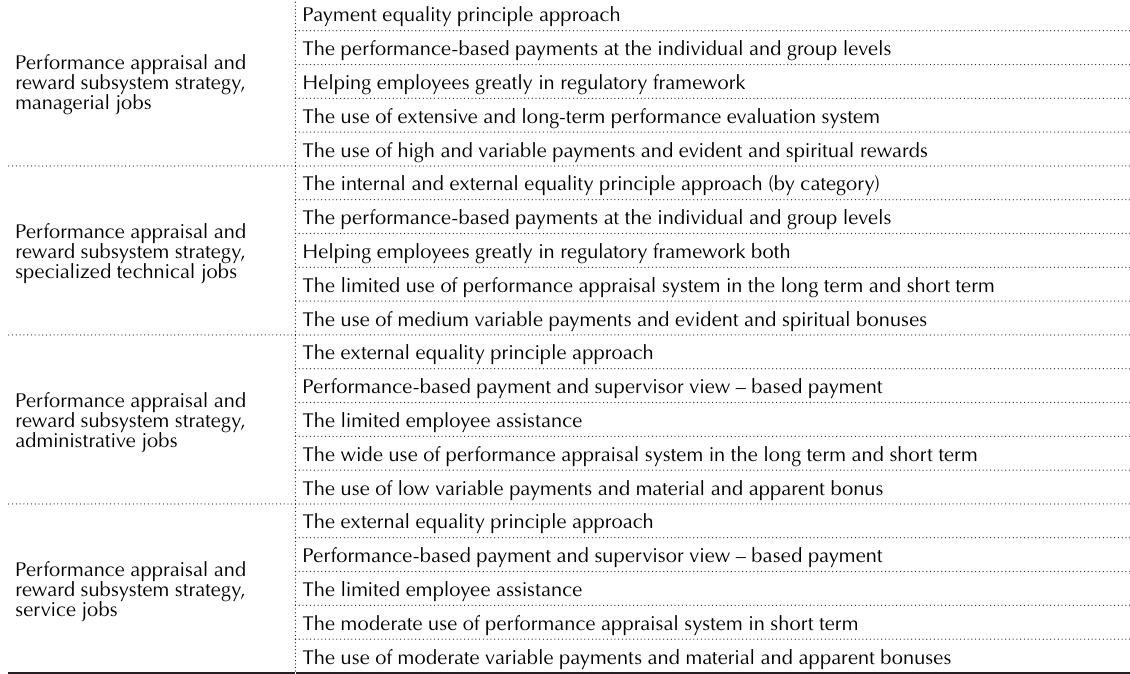
Table 10. The strategy of job performance appraisal and reward subsystem in the Civil Deputy of the Isfahan